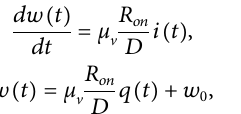
Frontiers in Physics |